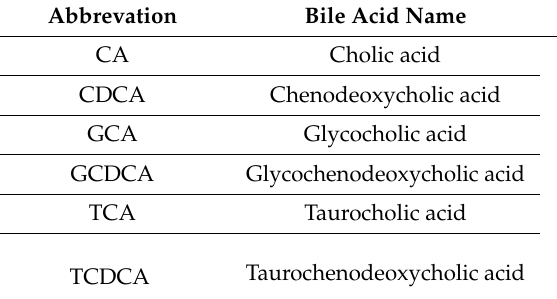
Table 1. Primary bile acids and their functions under physiological and pathophysiological conditions. (UC = ulcerative colitis, CRC = colorectal cancer, HCC = hepatocellular carcinoma).